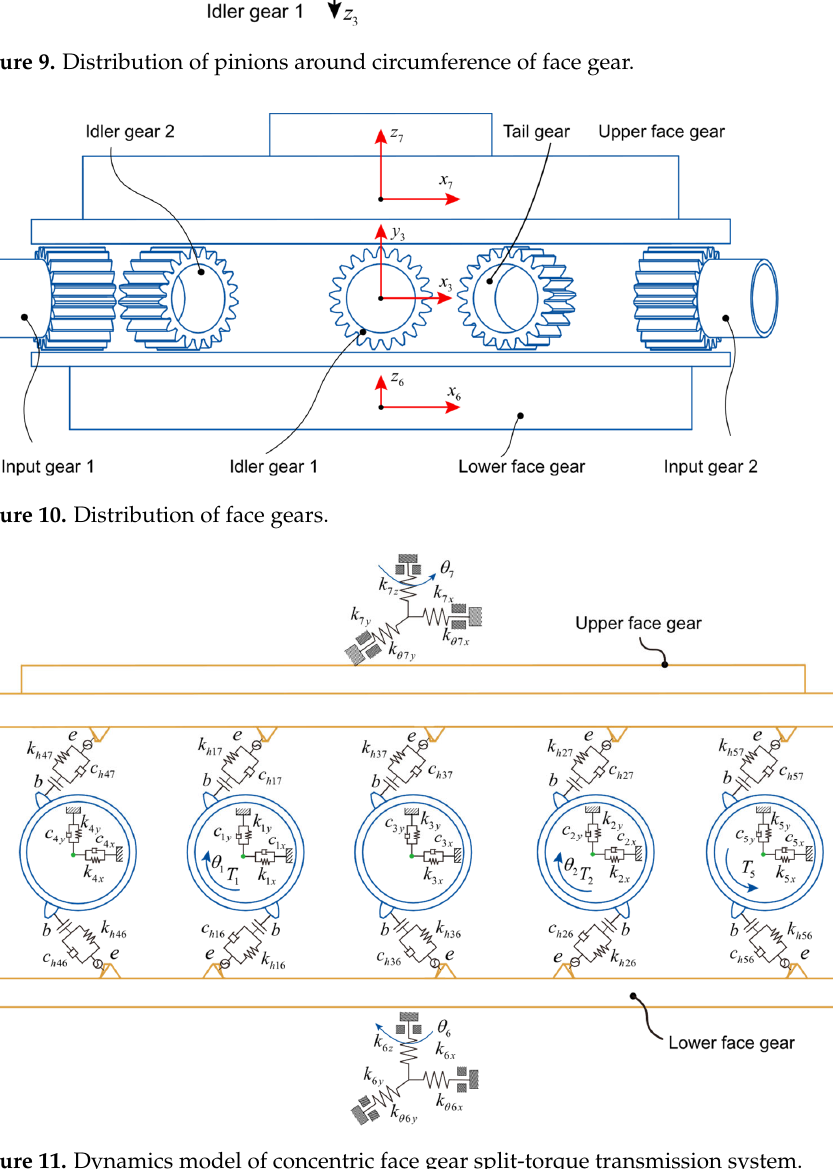
Figure 11. Dynamics model of concentric face gear split-torque transmission system.